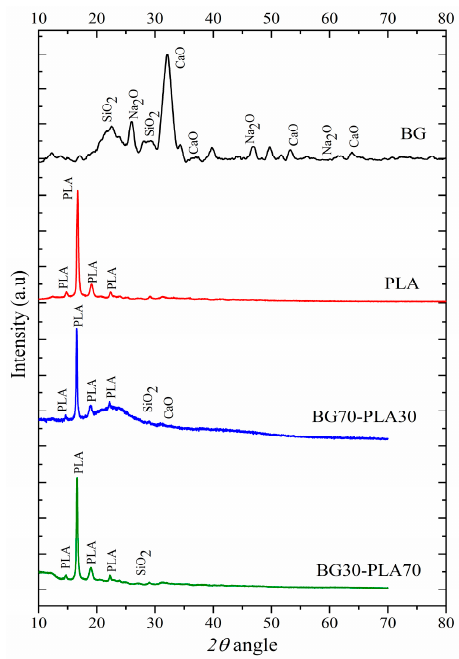
Figure 1. X-ray diffraction for the obtained materials.